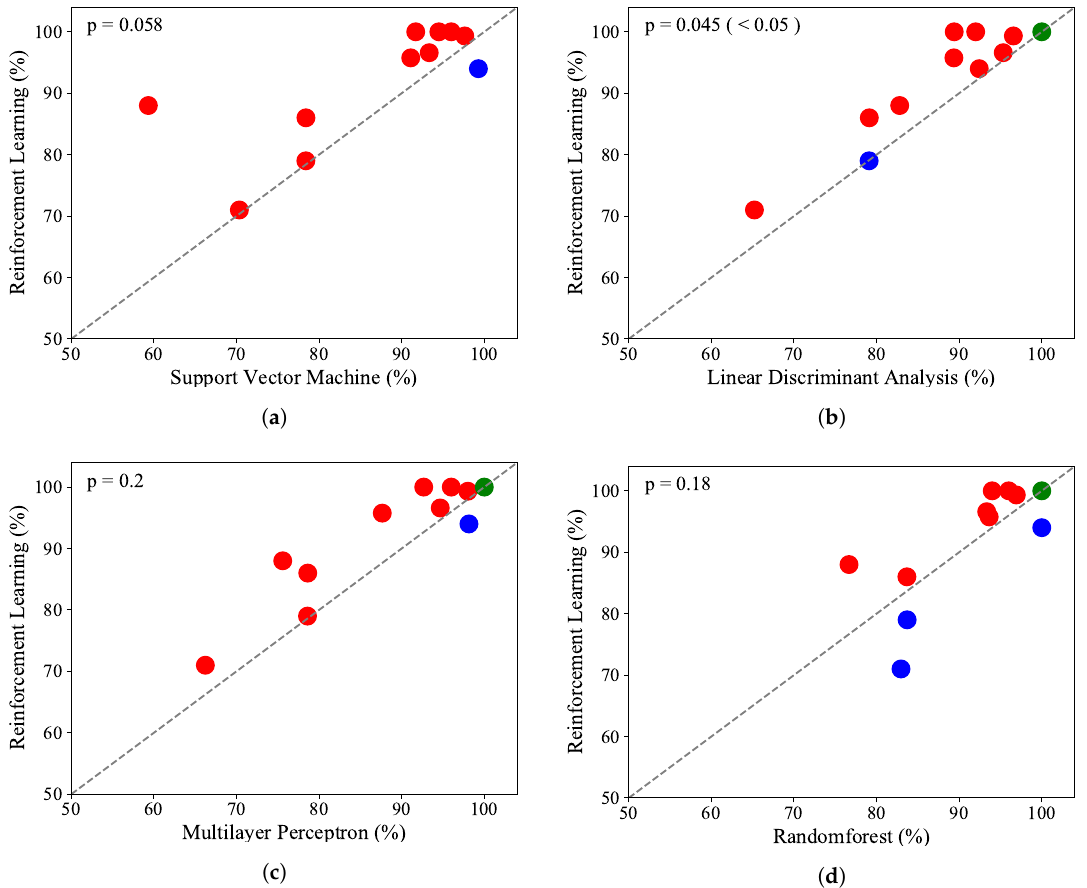
Figure 5. Scatter plots for the classification results of the 11 subjects compared with the results of conventional classifiers. ( a ) scatterplot of the classification rates comparing RL classifier with SVM; ( b )scatterplot of the classification rates comparing RL classifier with LDA; ( c ) scatterplot of the classification rates comparing RL classifier with MLP; ( d ) scatterplot of the classification rates comparing RL classifier with